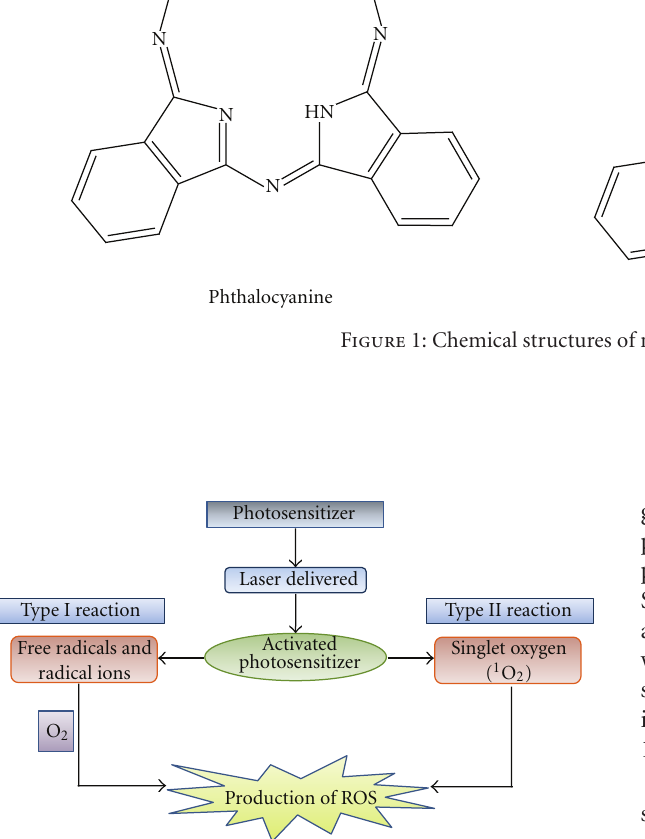
Figure 2: Mechanisms leading to the formation of ROS. There are two types of reactions during PDT. In Type I reaction, the triplet photosensitizer reacts with the neighboring substrate and forms free radicals as well as radical ions, which further interact with molecular oxygen and produce ROS. In Type II reaction, the triplet photosensitizer transfers its energy directly to molecular oxygen and form excited-state singlet